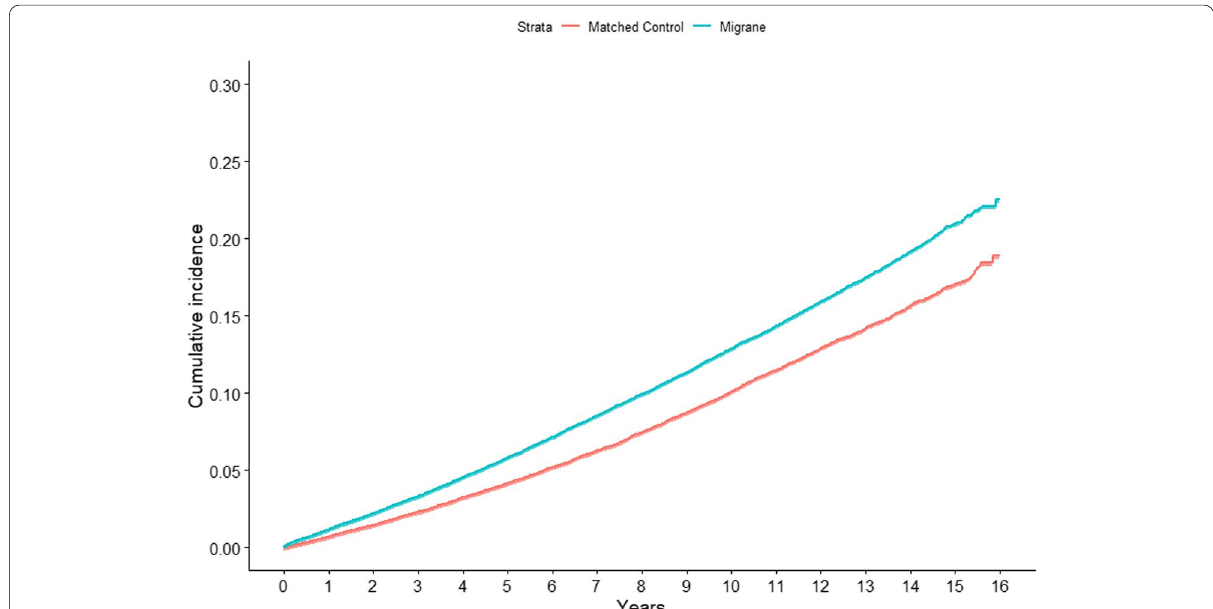
Fig. 2 Cumulative incidence of all‑cause dementia in migraine patients and their risk set‑matched controls during follow‑up. p ‑values for stratified log‑rank tests <